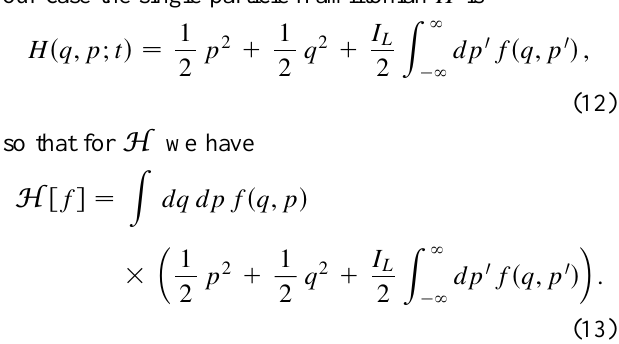
FIG. 1. Examples of charge density profiles r 0 (cid:2) q (cid:3) of Haïssin- ski distributions for I L . 0 (displaying bunch lengthening), I L , 0 (displaying bunch shortening), and I L (cid:1) 0 (Gaussian